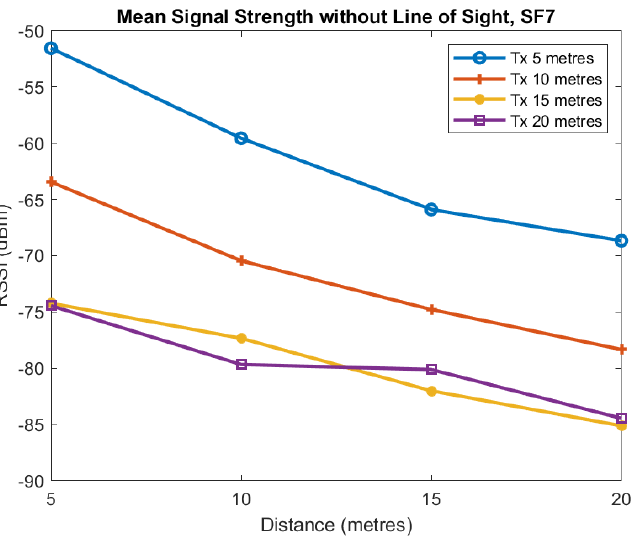
Figure 15. Mean RSSI against receiver distance from junction for different transmitter distances from junction,